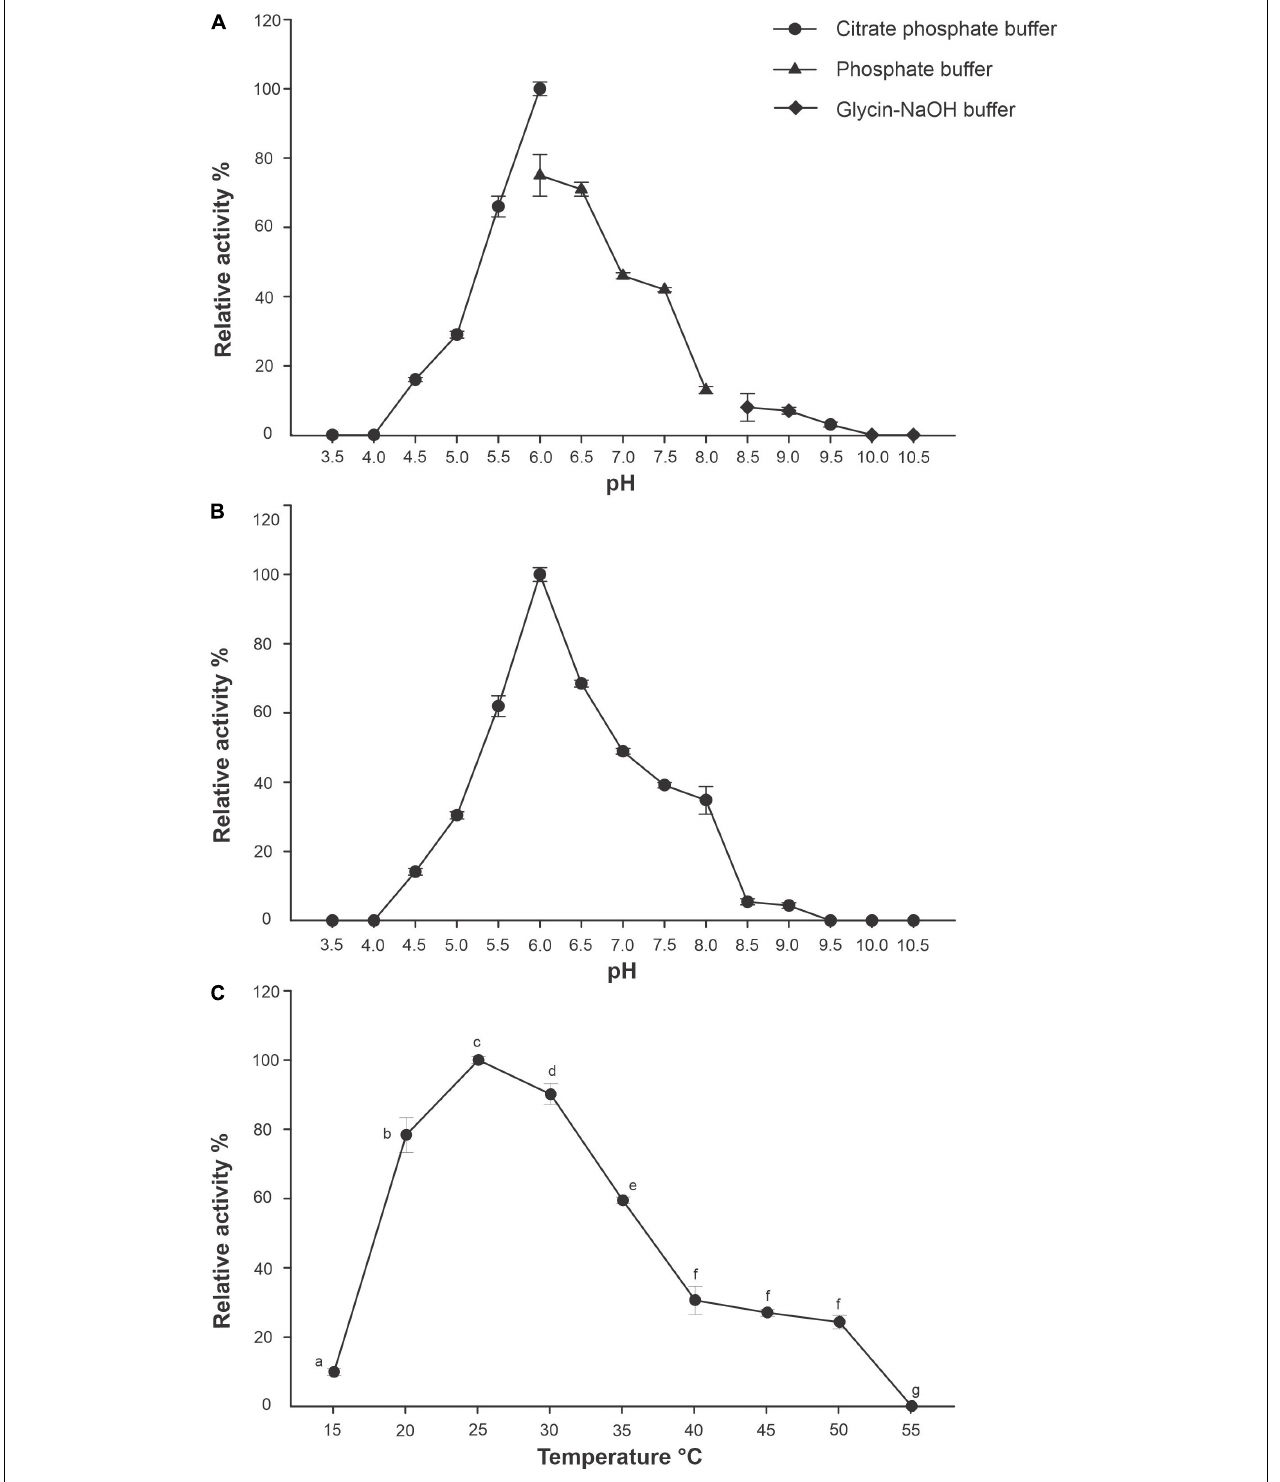
FIGURE 6 | Effect of pH and temperature of R13 Fae activity and stability. (A) pH effect with different buffers ( n = 3): citrate (pH 3.5–6.0), phoshate (pH 6.0–8.0), and glycine-NaOH (pH 8.5–10.5) incubated at 25 ◦ C for 60 min. (B) pH stability ( n = 3), the protein was incubated in buffers mentioned above at different pH values, ranging from 3.5 to 10.5 at 25 ◦ C for 2 h. (C) Temperature effect ( n = 3), the enzyme was incubated with 1.0% (w/v) beechwood xylan dissolved in 50 mM citrate buffer at pH 6.0 for 30 min at different temperatures (15–55 ◦ C). Different lower case letters indicate statistical significance ( p < 0.001).